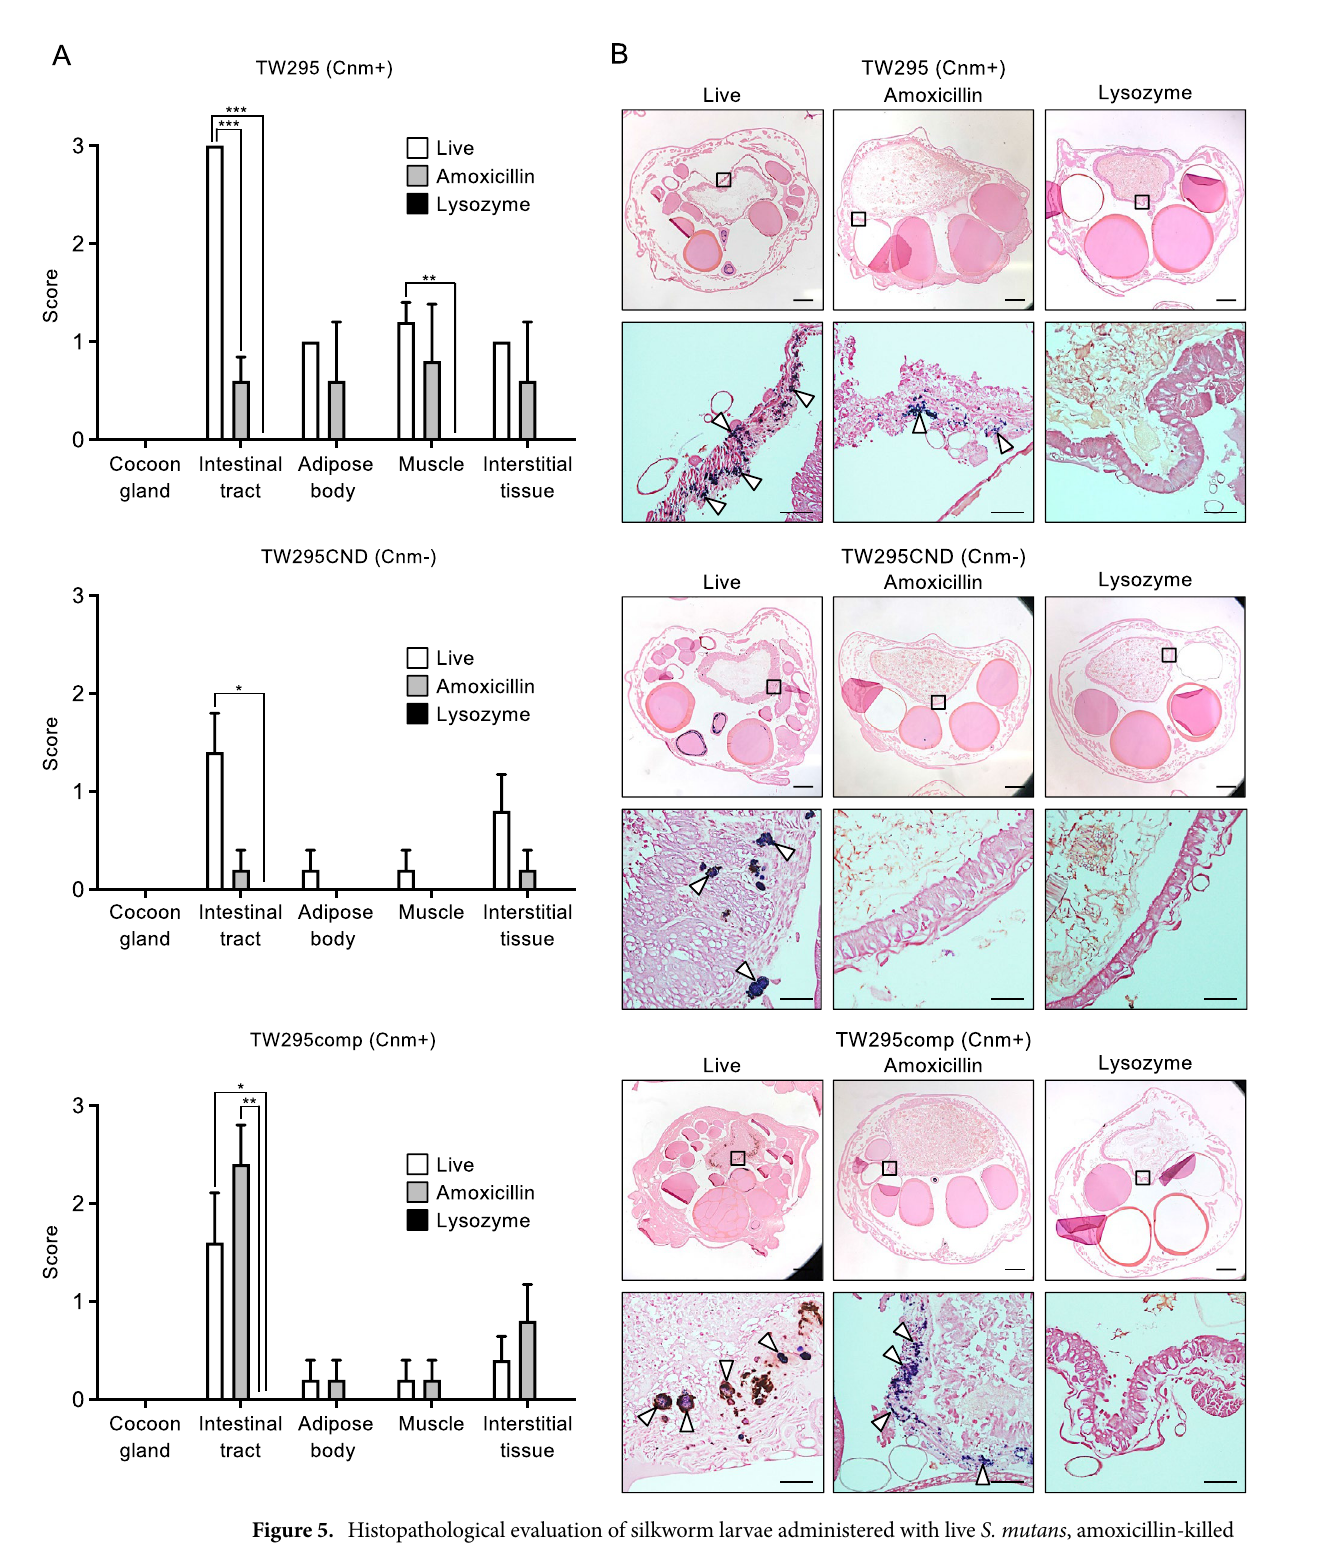
Figure 5. Histopathological evaluation of silkworm larvae administered with live S. mutans , amoxicillin-killed S. mutans , and lysozyme-killed S. mutans . ( A ) Scoring for the localization of bacteria in tissue sections of each organ. Significant differences were observed using analysis of variance with Bonferroni correction (* P < 0.05, ** P < 0.01, and *** P < 0.001). ( B ) Representative histopathological images following Gram staining of tissue sections of the intestinal tract from silkworms euthanized 72 h after S. mutans administration. Lower panels show high-magnification images of the boxes on the upper images. White arrowheads indicate bacterial masses. Bar = 1 mm (upper images) and bar = 100 μm (lower